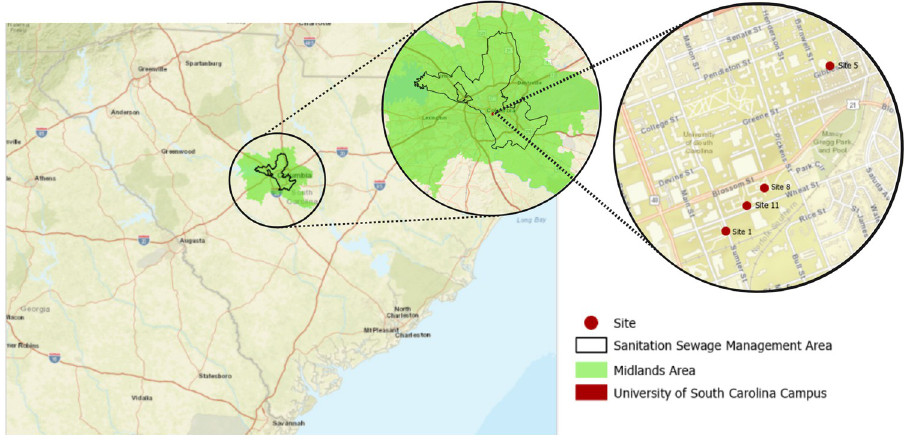
Fig 2. Locations of wastewater sampling at the University of South Carolina within the greater Columbia metropolitan area. Figure was rendered using ArcGIS Pro. Green area represents the ZIP codes within the greater Columbia metropolitan area. Black outlined region represents the sanitation sewage management area. Red dots represent the sampling sites within the University of South Carolina campus. Numbered sites not included in this study are not